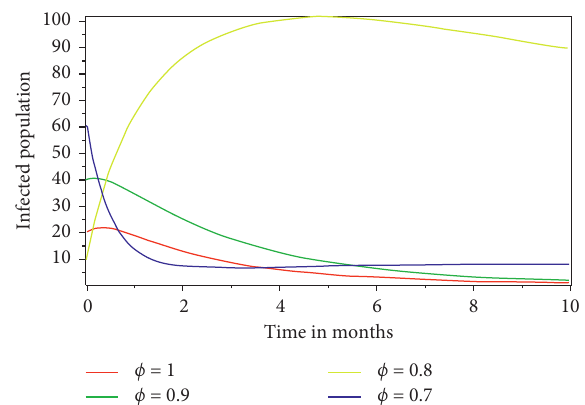
Figure 3: Approximate solution of infectious cows.